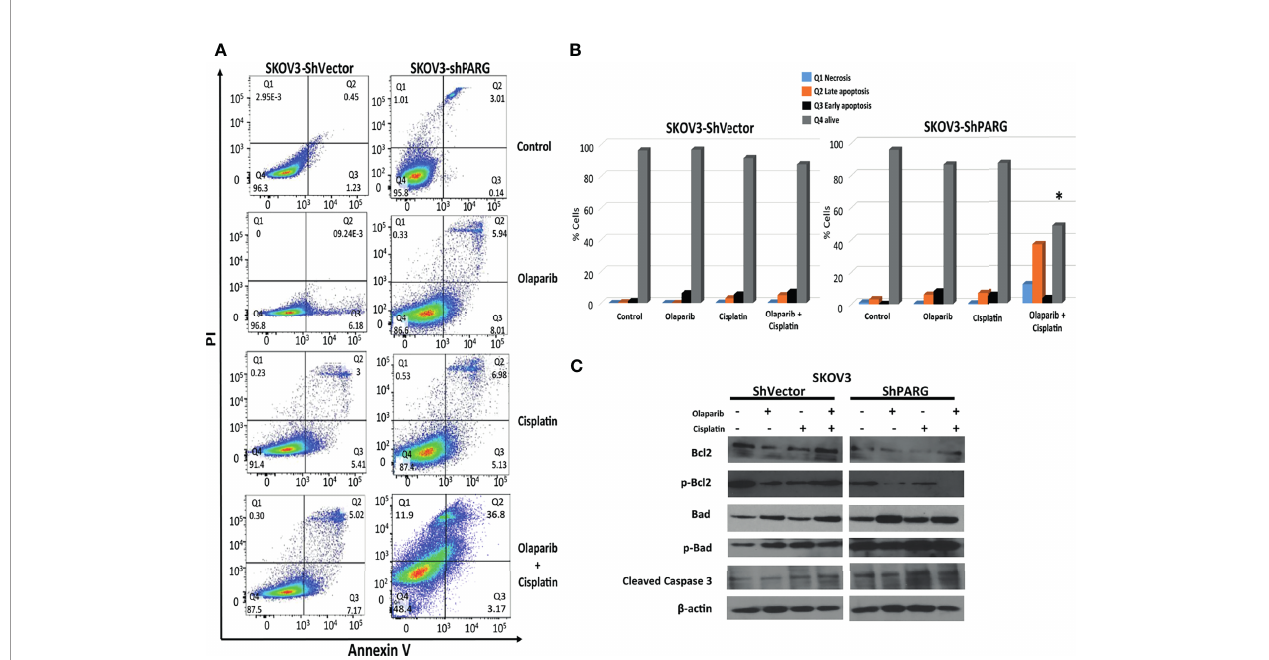
FIGURE 6 | PARG silencing induces apoptosis in ovarian cancer cells treated with Olaparib and Cisplatin. SKOV3-shVector and SKOV3-shPARG cells were treated with Olaparib 2 m M, Cisplatin 1 m g/mL and combination of Olaparib and Cisplatin for 48 hours, then apoptotic rates were assessed using Annexin V/PI double staining followed by fl ow cytometry analysis (A, B) . Protein expression of pro and anti-apoptotic proteins (Bcl2, p-Bcl, Bad, p-Bad, cleaved caspase3) were examined by western blot (C) . Results are presented as means ± SEM for triplicates of three independent experiments, *p value <